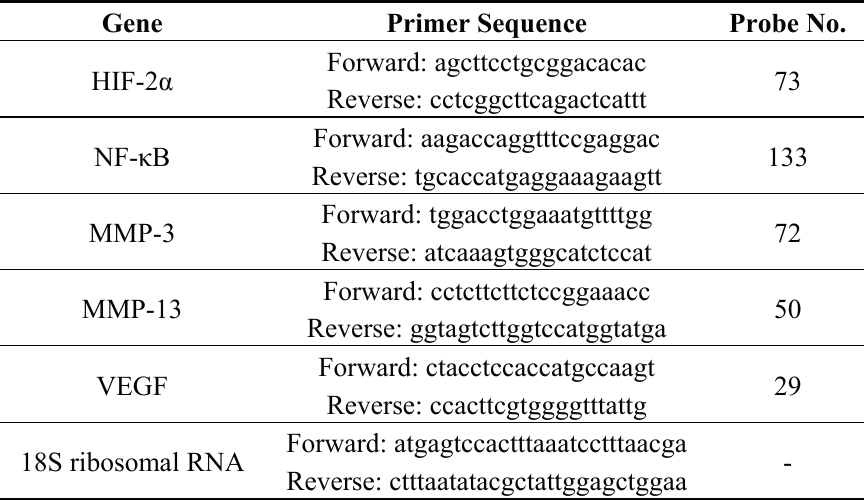
Table 1. Primers used for real-time